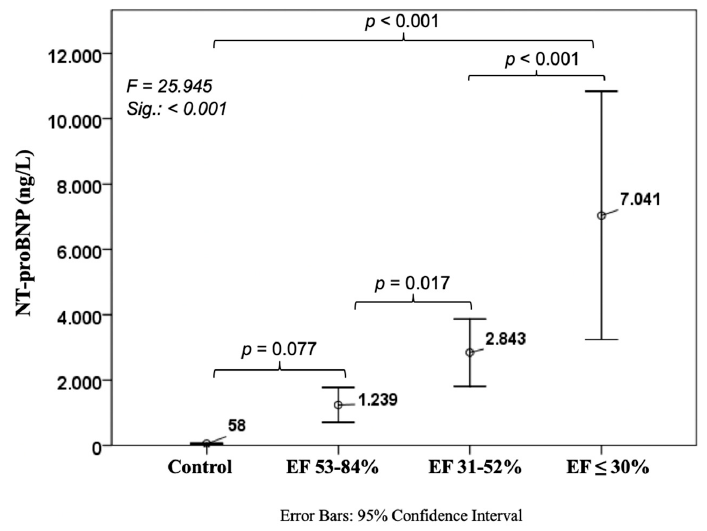
Figure 5. Course of N-terminal pro brain natriuretic peptide in ischemic heart disease. NT-proBNP: N-terminal pro brain natriuretic peptide.